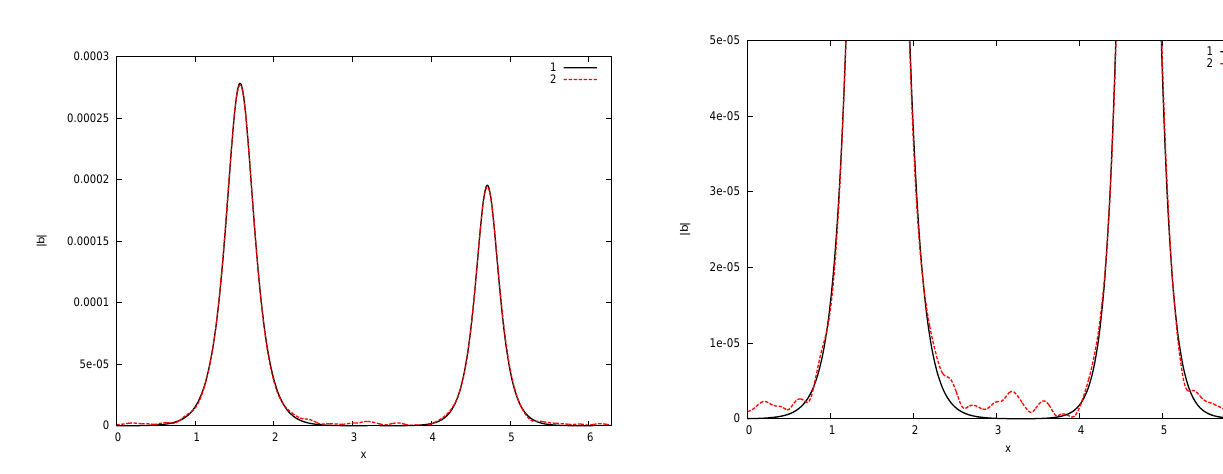
Fig. 10. Zoomed picture from Fig. Fig. 8. Modulus of b(x) for two points in time. The solid line cor- Figure 8. Modulus of b ( x ) for two point of time. Solid line corre- Figure 10. Zoomed picture from Figure 8. Figure 8. Modulus of b ( x ) for two point of time. Solid line corre- Figure 10. Zoomed picture from Figure 8. responds to the initial statement ( t = 0), the dashed line to the state sponds the initial statement ( t = 0), dashed line corresponds to the sponds the initial statement ( t = 0), dashed line corresponds to the after 100 breather collisions ( t ∼ 88 000). Figure 8. Modulus of b ( x ) for two point of time. Solid line corre- Figure 10. Zoomed picture from Figure 8. state after 100 breather collisions ( t 88000) state after 100 breather collisions ( t 88000) Figure 8. Modulus of b ( x ) for two point of time. Solid line corre- sponds the initial statement ( t = 0), dashed line corresponds to the Figure 10. Zoomed picture from Figure 8. ∼ ∼ sponds the initial statement ( t = 0), dashed line corresponds to the state after 100 breather collisions ( t 88000) ∼